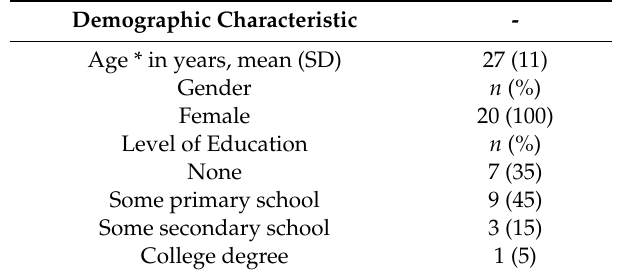
Table 2. Descriptive characteristics of vendors interviewed at mining site